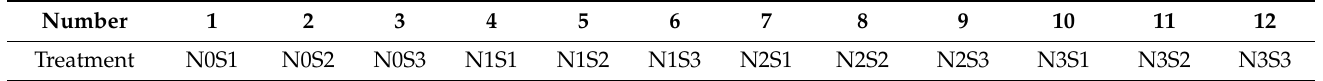
Table 2. The abbreviations of all